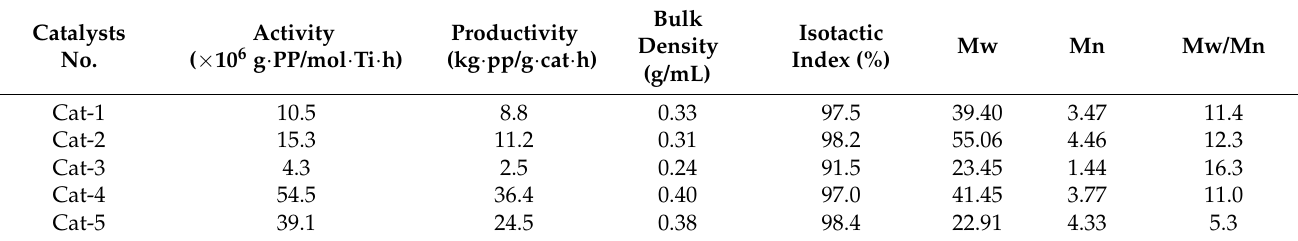
Table 3. Propylene polymerization evaluation results from the prepared POP-based and MgCl 2 -based Z–N catalysts.